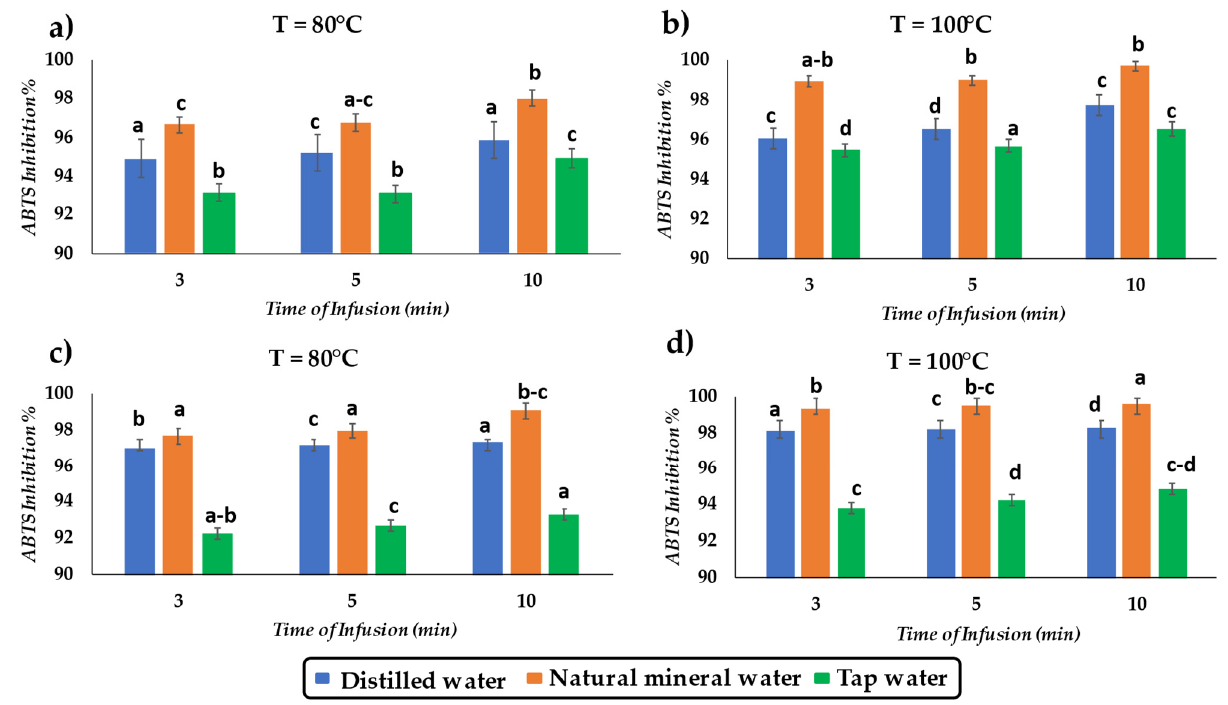
Figure 6. ABTS radical scavenging activity of green tea infusion, at T = 80 °C ( a ) and at T = 100 °C ( b ); and of black tea samples, at T = 80 °C ( c ) and at T = 100 °C ( d ); in distilled water; in natural mineral water, and in tap water. Error bars are ±standard deviation. Same letters indicate a significant difference according to the ANOVA test ( p < 0.05).